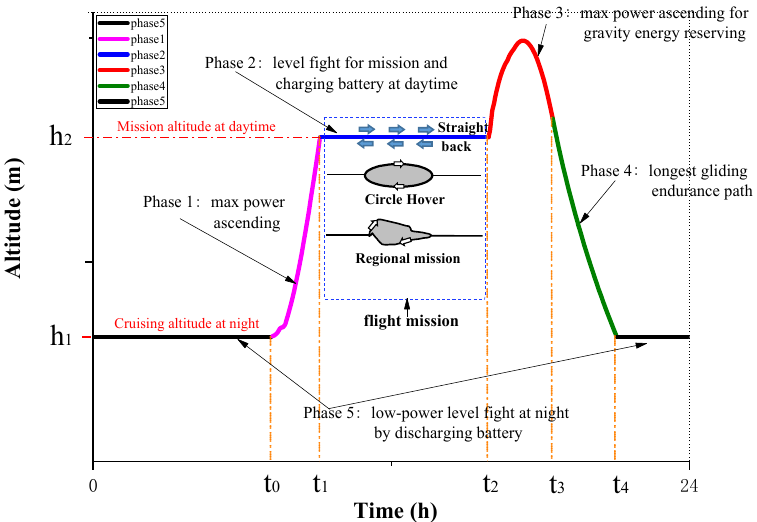
Figure 2. Scheme flight path phase map based on gravity energy storage and mission altitude.